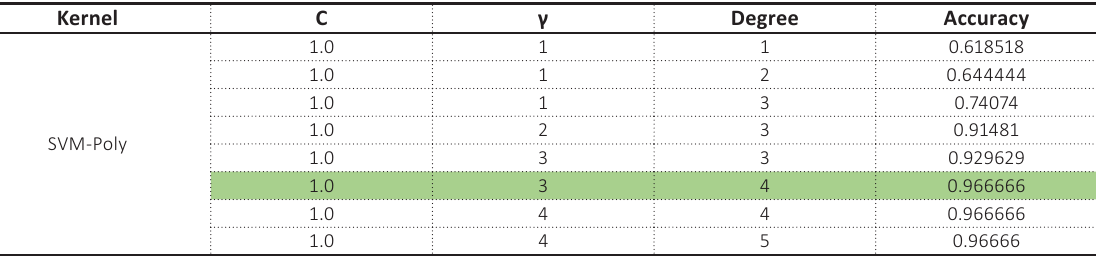
Table A7. The confusion matrix of the three kernels Matrix